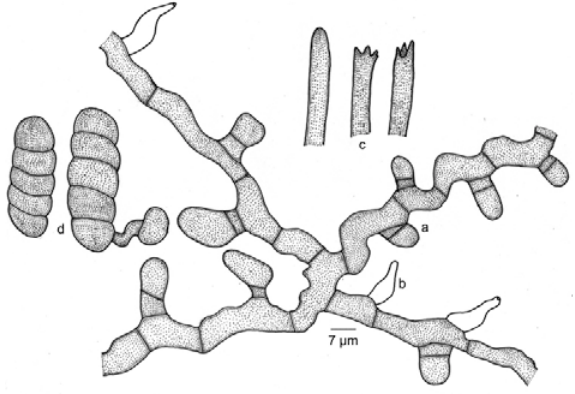
Figure 38. Meliola ailanthicola a - Appressorium; b - Phialide; c - Apical portion of mycelial setae; d -